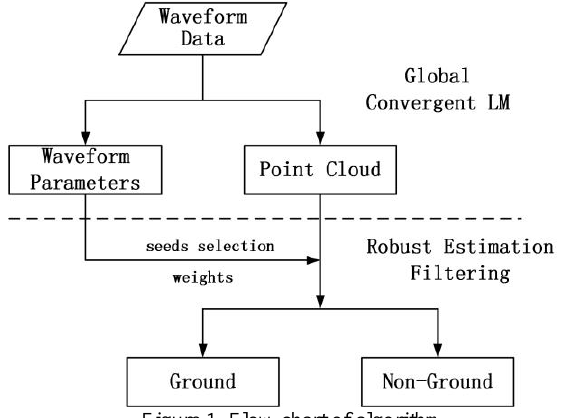
Figure 1. Flow chart of